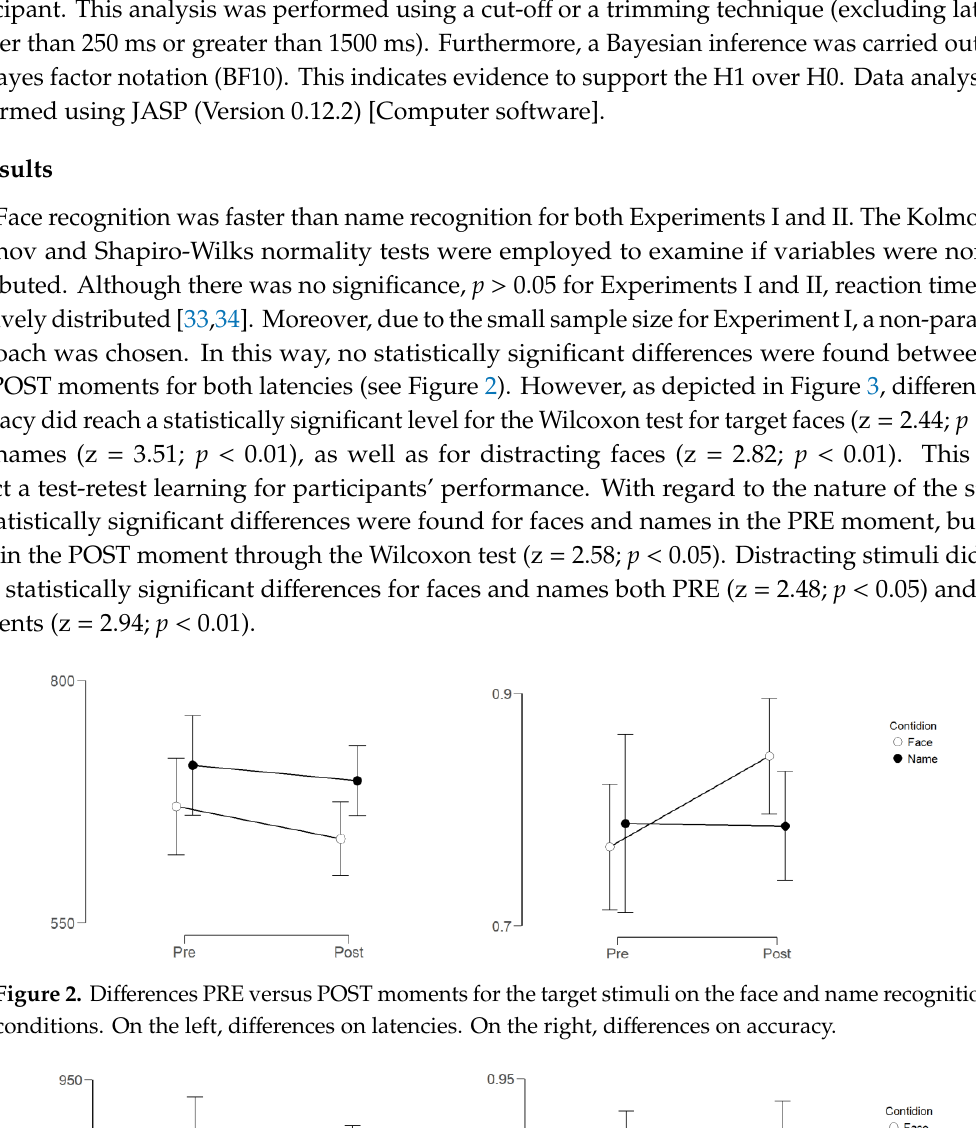
Figure 1. Visual representation of the experimental setup and conditions.